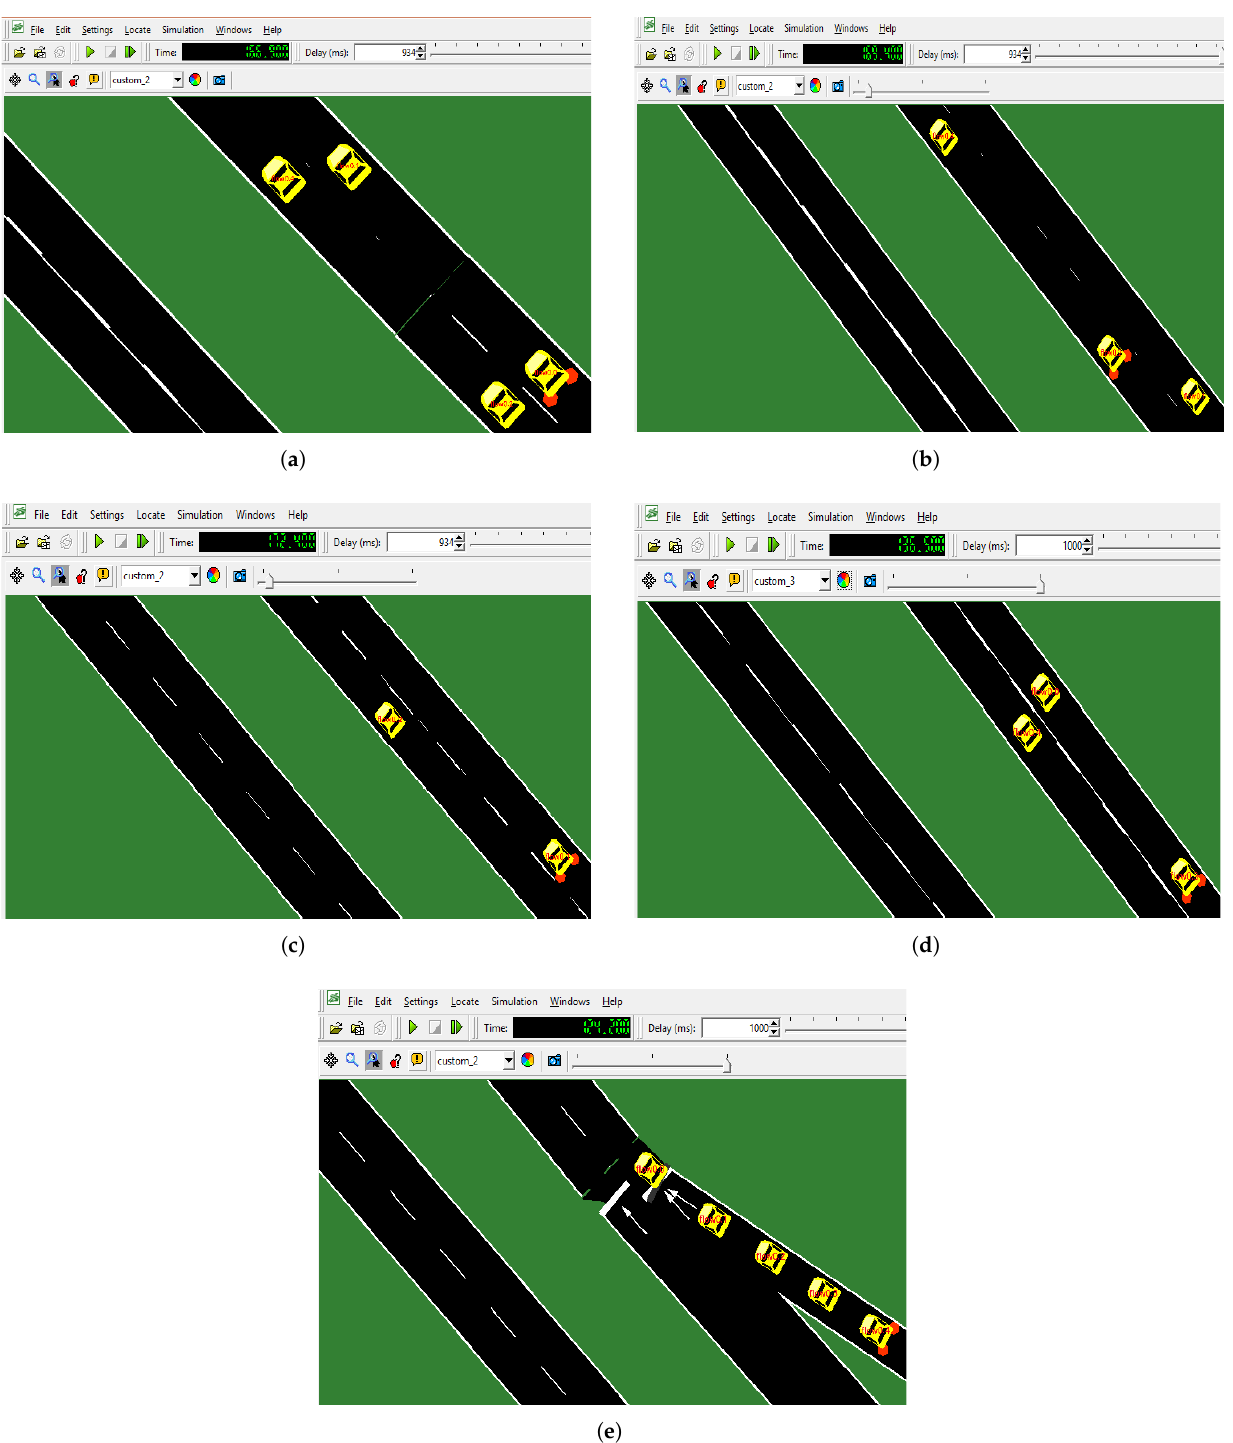
Figure 9. Tracked vehicles in SUMO. ( a ) Tracked vehicle 0 in SUMO as node 0.0. ( b ) Tracked vehicle 1 in SUMO as node 0.1. ( c ) Tracked vehicle 2 in SUMO as node 0.2. ( d ) Tracked vehicle 3 in SUMO as node 0.3. ( e ) Tracked vehicle 4 in SUMO as node